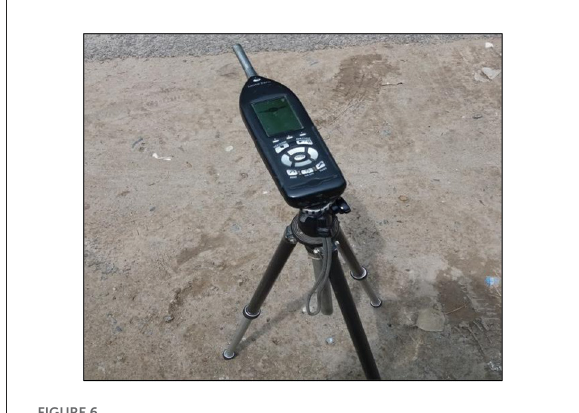
FIGURE6 Sound level meter Larson and Davis-831.